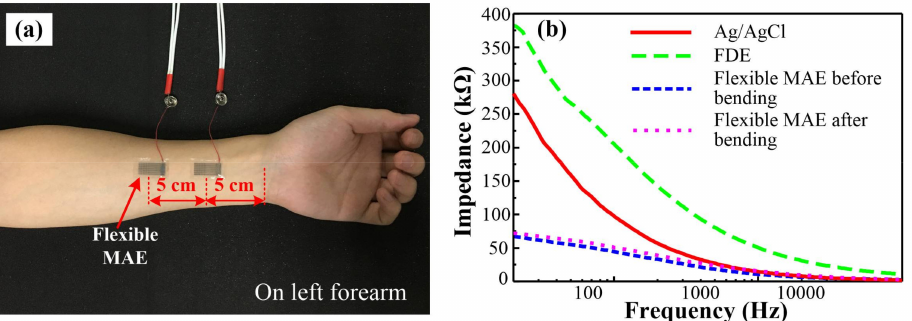
Figure 4. ( a ) EII measurement using flexible MAE, and ( b ) EII measured by the Ag/AgCl electrode, FDE, and flexible MAE before and after the bending